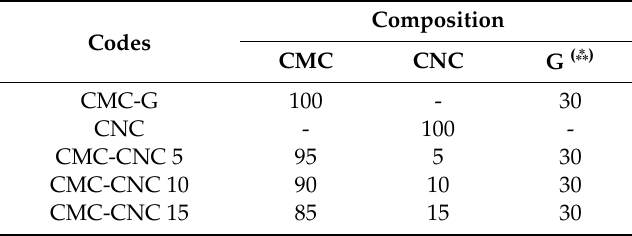
Table 1. Samples composition and codes.